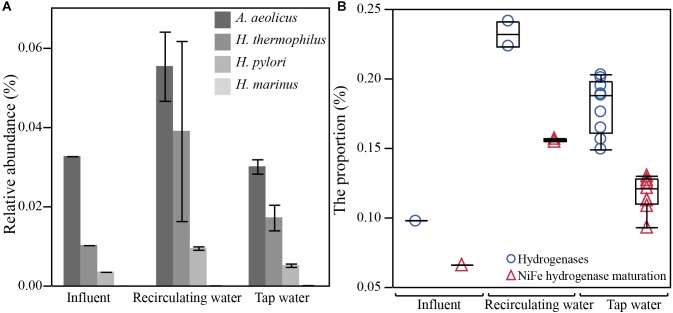
Increased abundance of taxonomic and functional gene markers associated with hydrogen metabolism in hot water. Increased (A) relative abundance of four known species of hydrogen-oxidizing bacteria and (B) proportion of genes responsible for hydrogen oxidation (hydrogenases and NiFe hydrogenase maturation) in hot waters sampled from the recirculating lines and taps, relative to the cold influent water (Influent). Relative abundance (%) or the proportion (%) was calculated by dividing the count of reads annotated as a particular species or as a gene encoding the particular function by total read counts in a sample. Error bars in panel A are standard deviations. The recirculating water group has 2 samples (ExpR and CtrR), and the tap water group has 9 samples from all three time-points. Box-plots in panel B show the maximum, 75th percentile, medium, 25th percentile, and minimum values.